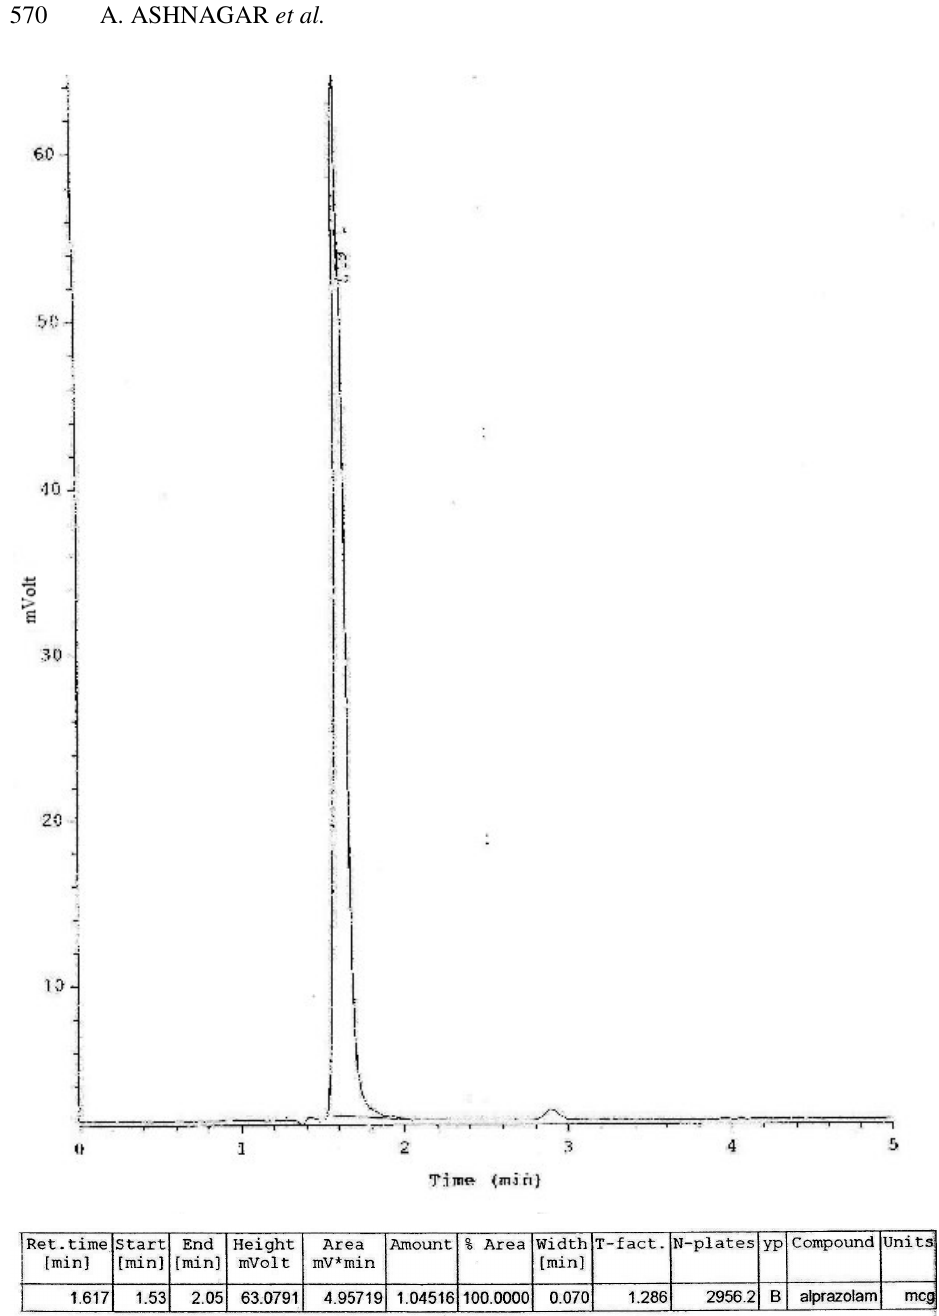
Figure 4 . HPLC Chromatogram and data peak report of alprazolam tablets active ingredient (assay) manufactured by Xanax (cid:1) (Upjohn) of